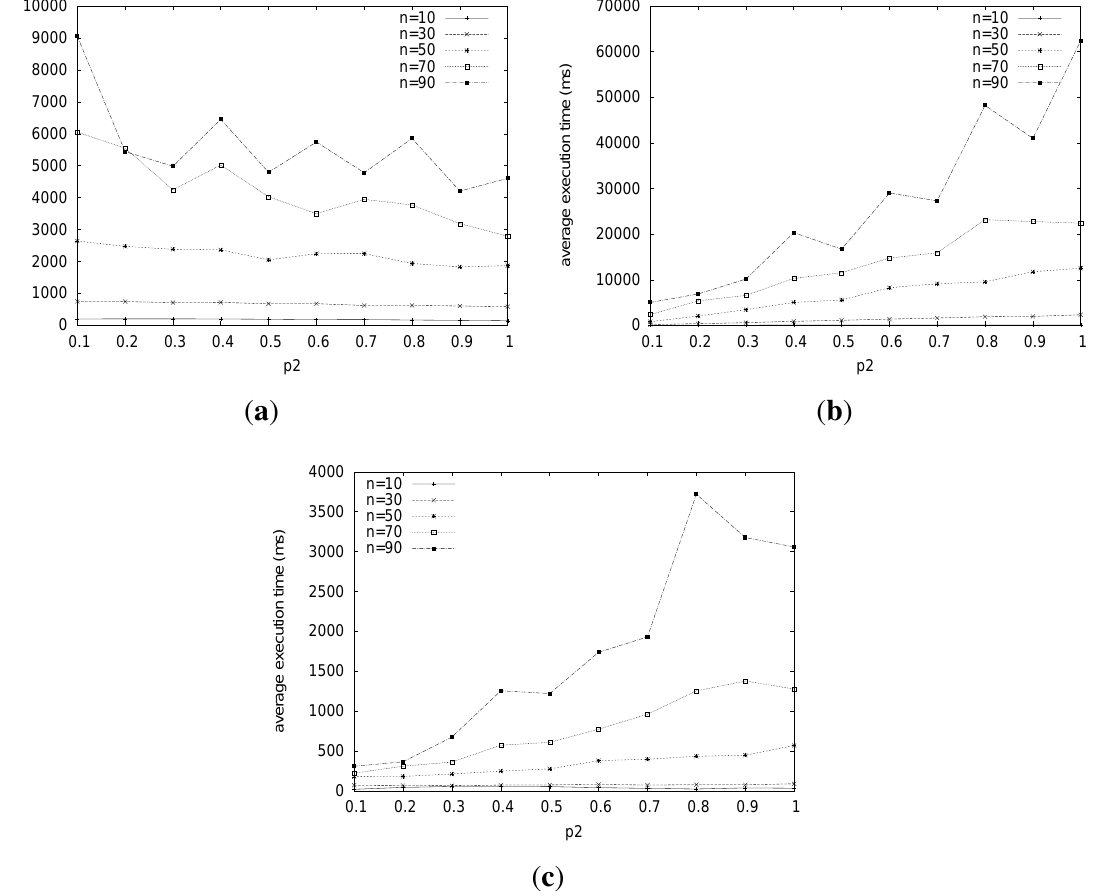
Figure 10. Average execution time for LTIU, LSTk and LSTt. ( a ) Average execution time for LTIU varying n for p = 0.8; ( b ) average execution time for LSTk varying n for p 1 and k = 50%; ( c ) average execution time for LSTt varying n for p